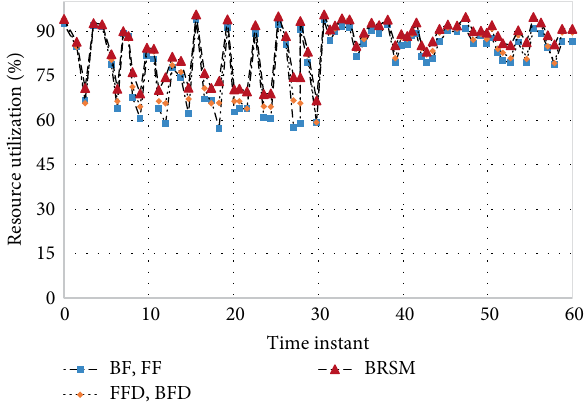
Figure 8: Comparison of real-time resource utilization of 5000 mobile services by FF, BF, FFD, BFD and